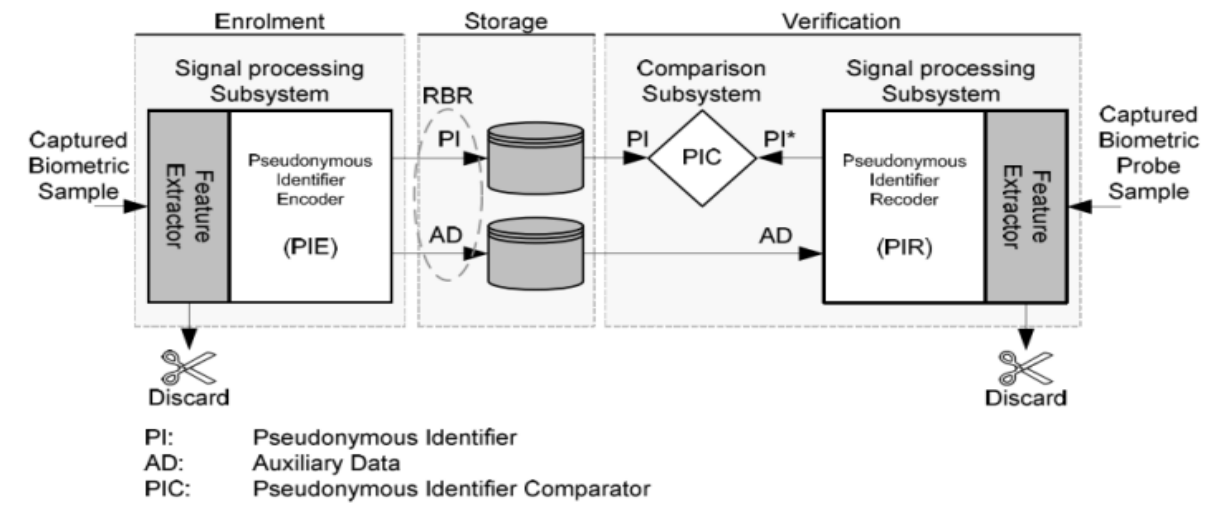
Figure 1. Reference architecture of template protection defined in